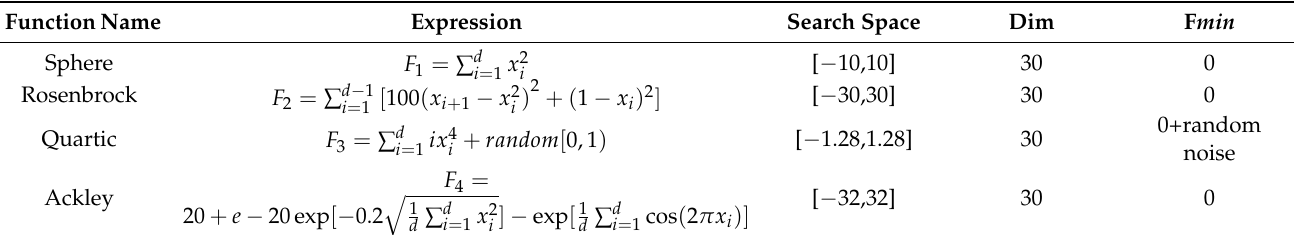
Table 1. Test functions and specific information.